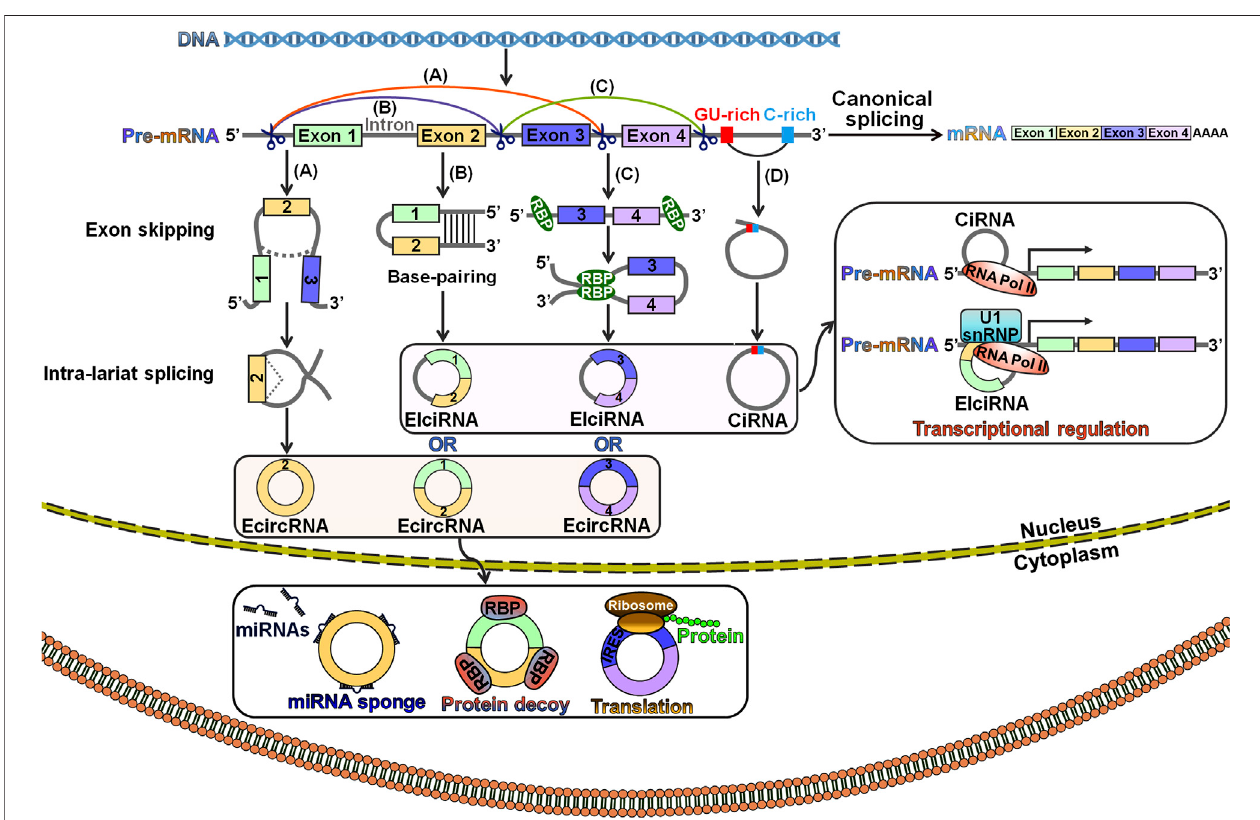
FIGURE 1 | Schematic illustration of the biogenesis and functionality of circRNAs. (A) Lariat-driven circularization. A lariat containing exons is generated following the exon-skipping event. The lariat is then internally spliced, thus giving rise to an ecircRNA. (B) Intron pairing-driven circularization. Pre-mRNA fl anking introns harbor complementary sequences or inverted repeats. The base-pairing of both sides of the introns leads to the creation of a circular structure. In this case, circRNAs can be grouped into ecircRNAs and EIciRNAs depending on whether the intronic sequences reside in the loop. (C) RBP-mediated circulation. RBPs can speci fi cally interact with fl anking introns that bring the back-spliced exons close together and promote the circulation. As a result, ecircRNAs or EIciRNAs are generated. (D) BiogenesisofciRNA.CiRNAsareformedthroughalariat-derivedmechanism,whichpredominantlyrelyonconservedmotifsencompassinga7 ntGU-richelementnear the 5 ′ splice siteand an11 nt C-rich element nearthe branch point within theintrons.EIciRNAsand ciRNAs mainly locatein thenucleus, while the majority ofecircRNAs are exported to the cytoplasm. EIciRNAs and ciRNAs function to modulate the transcription of parental genes, while ecircRNAs can serve as miRNA sponges, protein decoys or templates for protein translation. Pre-mRNA, precursor mRNA; ecircRNA, exonic circRNA; miRNAs, microRNAs; EIciRNA, exon-intron circRNA; RBP, RNA- binding protein; IRES, internal ribosome entry site; ciRNA, circular intronic RNA; RNA Pol II, RNA polymerase II; U1 snRNP, U1 small nuclear ribonucleoprotein.